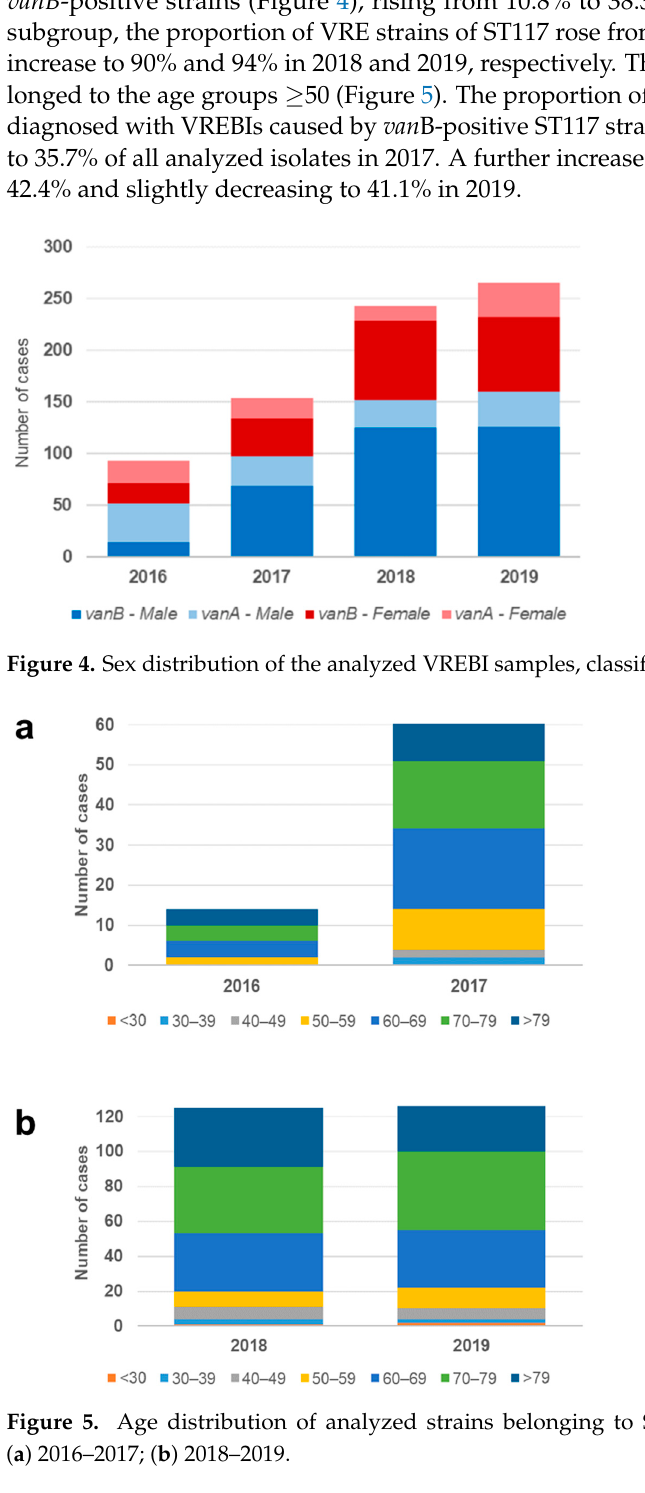
Figure 3. Temporal and spatial spread of VREBIs in NRW between 2016 and 2019: ( a ) geographic spread of VREBIs across administrative districts; ( b ) evolution of VREBI incidence; ( c ) distribution of resistance determinants; ( d ) proportion of ST117.